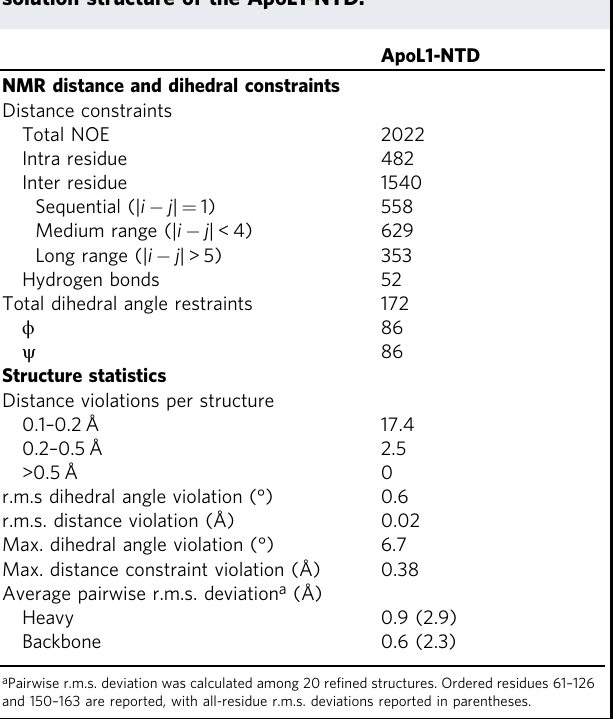
Table 2 Structural statistics for the NMR assignments and solution structure of the ApoL1-NTD.